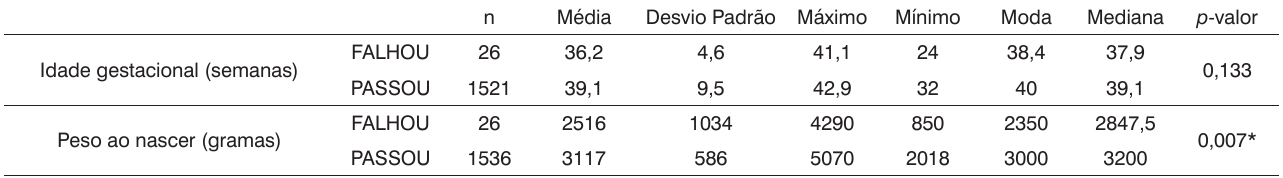
Tabela 1. Características demográficas dos 1570 recém-nascidos estudados, segundo resultado do